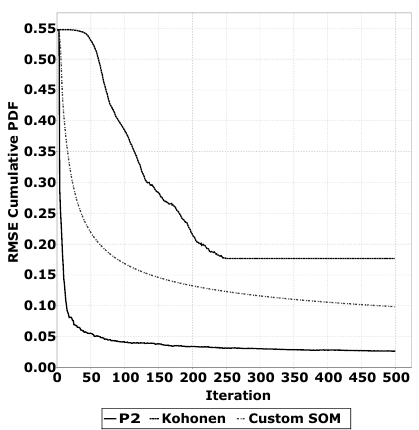
Figure 9. Accuracy of QUEST algorithm when using different quantile estimation heuristics over multiple